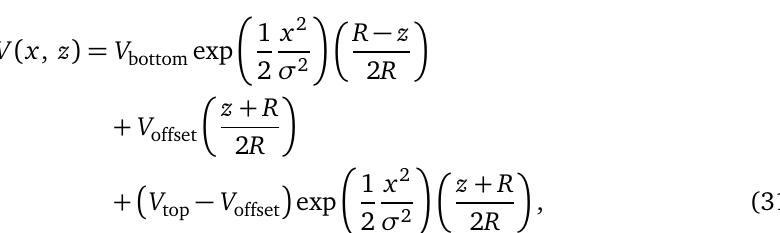
Figure 11: Potential shape inside the nanowire as given by Eq. (31). The param- eter values for the simulations in Fig. 9 are V = − 50 meV, and R = 35 V offset